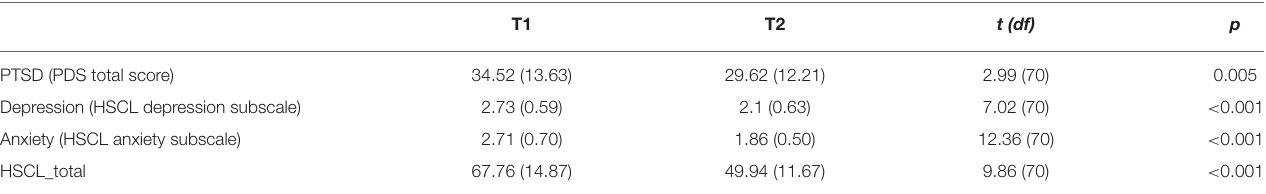
TABLE 2 | Symptom severity (M/SD) of PTSD, depression and anxiety at T1 and T2.